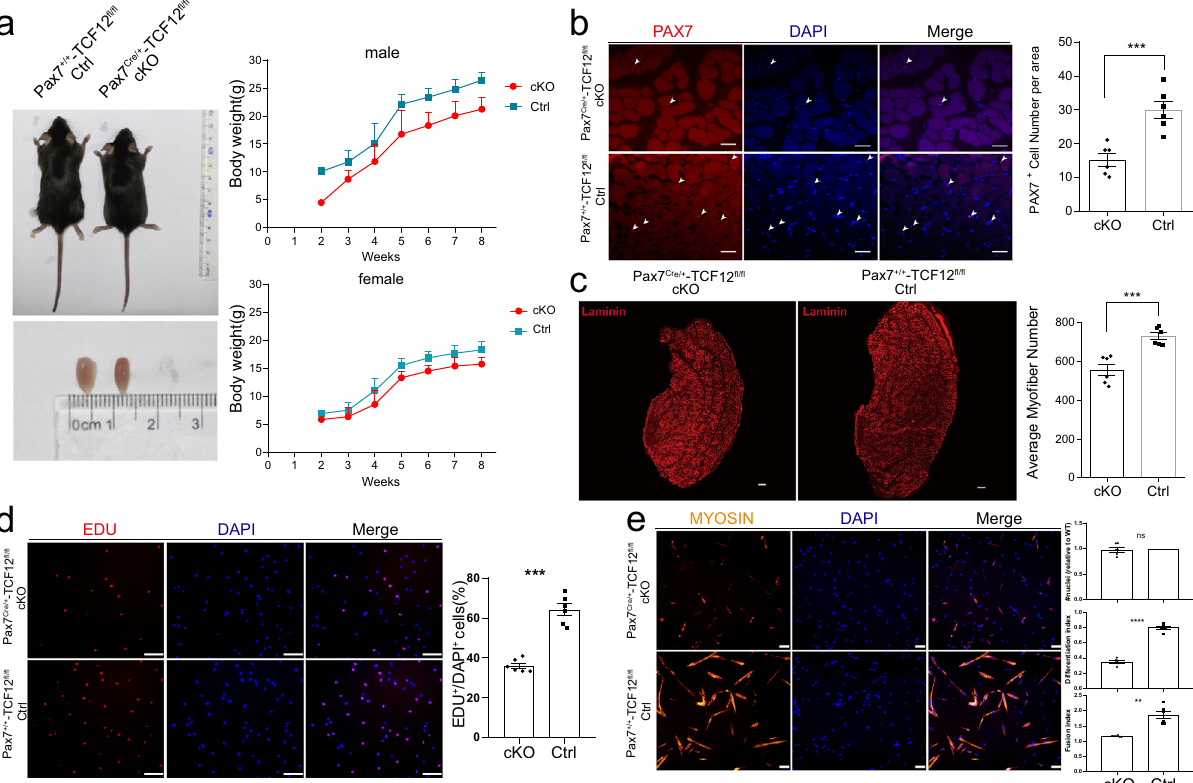
Fig. 1 TCF12 deletion in MuSCs and muscle lineage cause defects in muscle development. ( a ) Representative images of the 2-month-old Pax7 + / + - TCF12 fl / fl (Control, Ctrl) or Pax7 Cre/ + -TCF12 fl / fl (TCF12cKO, cKO) mice and images of their TA (tibialis anterior) muscles (left panel). Body weight of the Ctrl and TCF12cKO mice as recorded from 2 weeks after birth to 8 weeks (right panel); ( b ) Immuno fl uorescence (IF) staining for Pax7 and DAPI in the TA muscles of the TCF12cKO and Ctrl mice. Arrowheads point to the Pax7 + cells. Quanti fi cation of the Pax7 + MuSCs per area is shown on the right ( n = 6); ( c ) IF staining for laminin in the TA muscles of the TCF12cKO and Ctrl mice; Quanti fi cation of average myo fi ber number is shown on the right ( n = 6); ( d ) An equal number of isolated MuSCs from the TCF12cKO and Ctrl mice were cultured for 24 h and incubated with EdU for 2 h for immunostaining analysis (red). Quanti fi cation of the percentage of EdU-positive cells is shown on the right ( n = 6); ( e ) Isolated MuSCs were cultured in a proliferation medium followed by 2-day differentiation. The extent of differentiation was visualized by IF staining of MYOSIN, and quanti fi ed by differentiation and fusion indexes. Total number of nuclei in both TCF12cKO and Ctrl were equivalent ( n = 6). Scale bars = 100 μ m. Data are expressed as the mean ± SEM. n.s. not signi fi cant, * P < 0.05, ** P < 0.01, *** P <